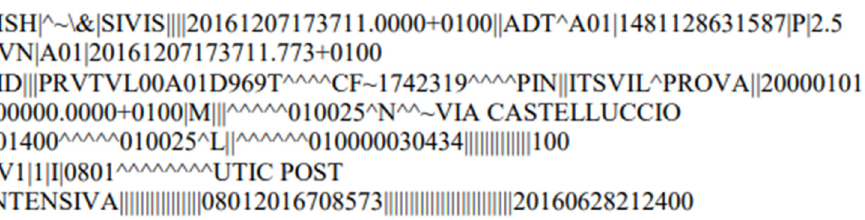
Figure 5. Admission system by HL7 V2 ADT messages.